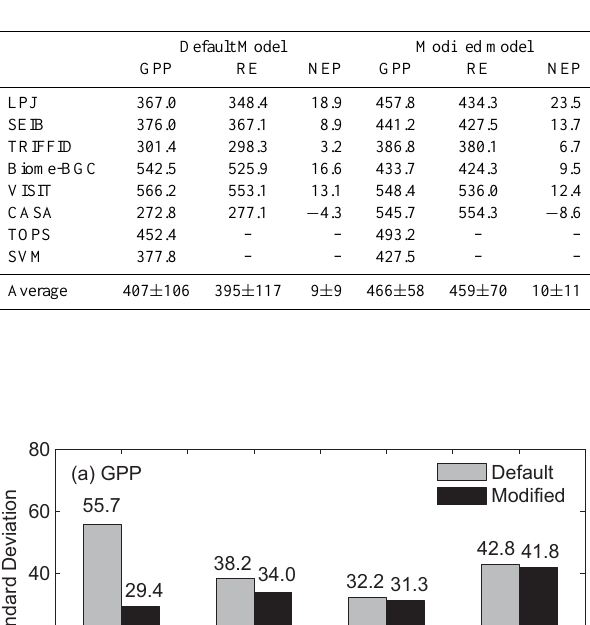
Table 4. Simulated annual carbon budget in Japan from 2001–2006. Units are TgCyr − 1 .